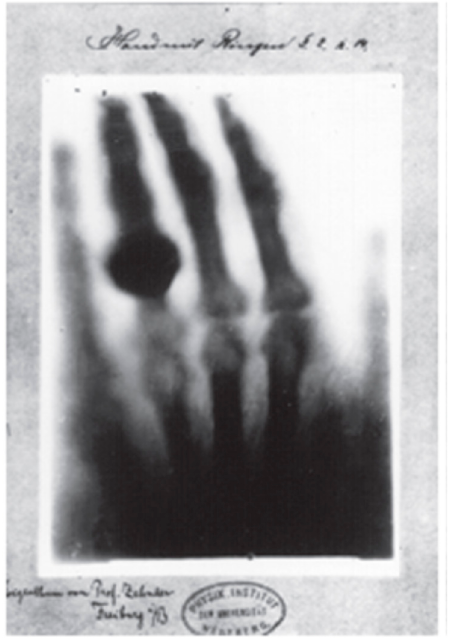
Figure 2. X-ray picture taken by Roentgen of his wife Bertha Ludwig’s hand. (Courtesy: Prof. Alok Mukherjee, Jadavpur University, Kolkata, India).